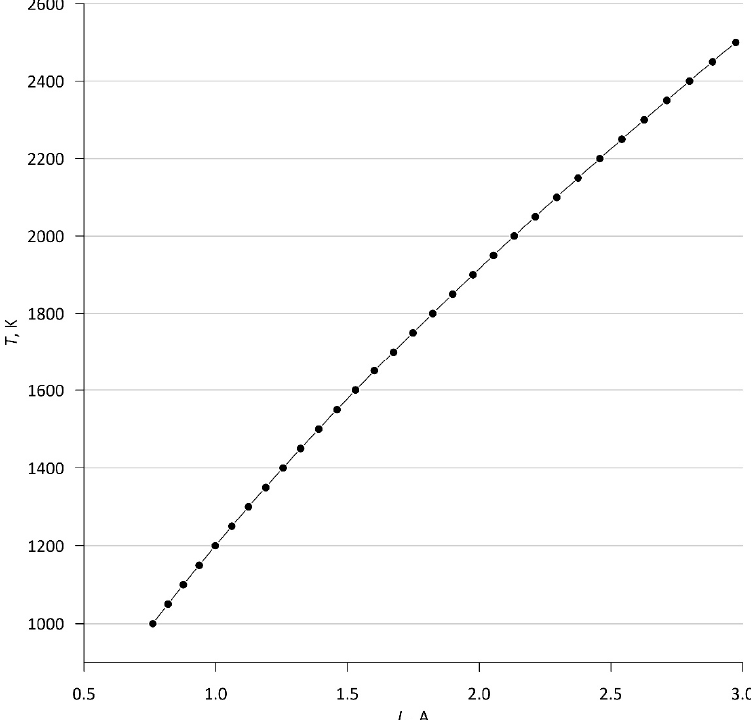
Figure A1. Model dependence of the cathode temperature T as a function of the cathode heating current I c , for tungsten cathode with dimensions d = 0.00012 m and l = 0.045 m. Then, using the Richardson-Dushmann equation, the dependence of the intensity I e . of the emission current as a function of the temperature T was determined. The results are presented in Figure A2.